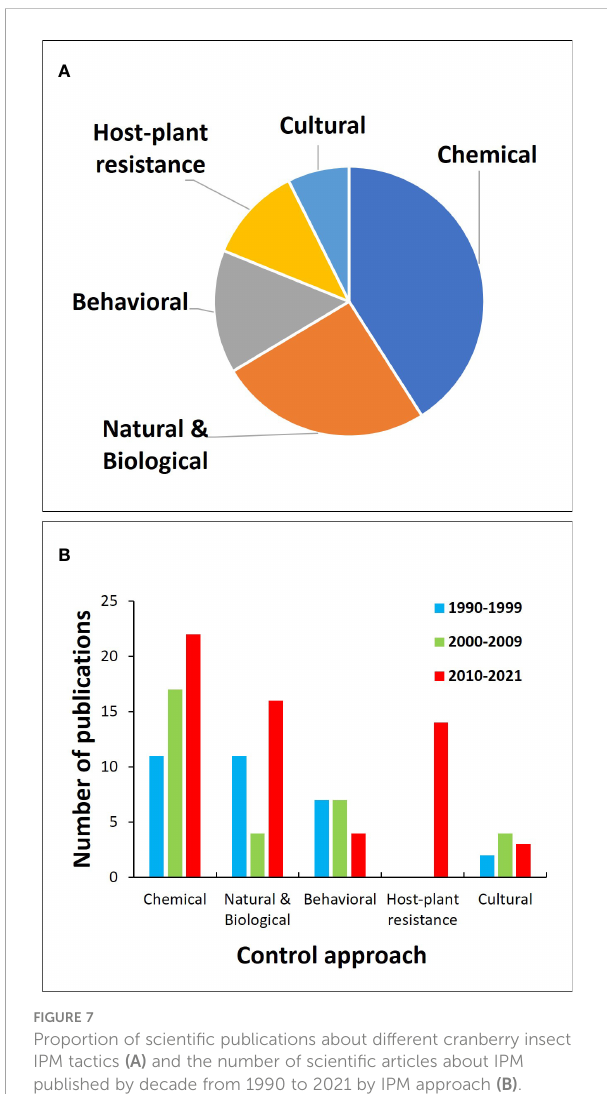
FIGURE 7 Proportion of scienti fi c publications about different cranberry insect IPM tactics (A) and the number of scienti fi c articles about IPM published by decade from 1990 to 2021 by IPM approach (B) .